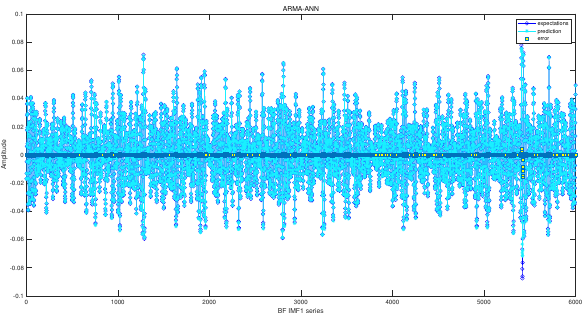
Figure 8. Prediction result of ARMA-ANN model for BF IMF1 time series.